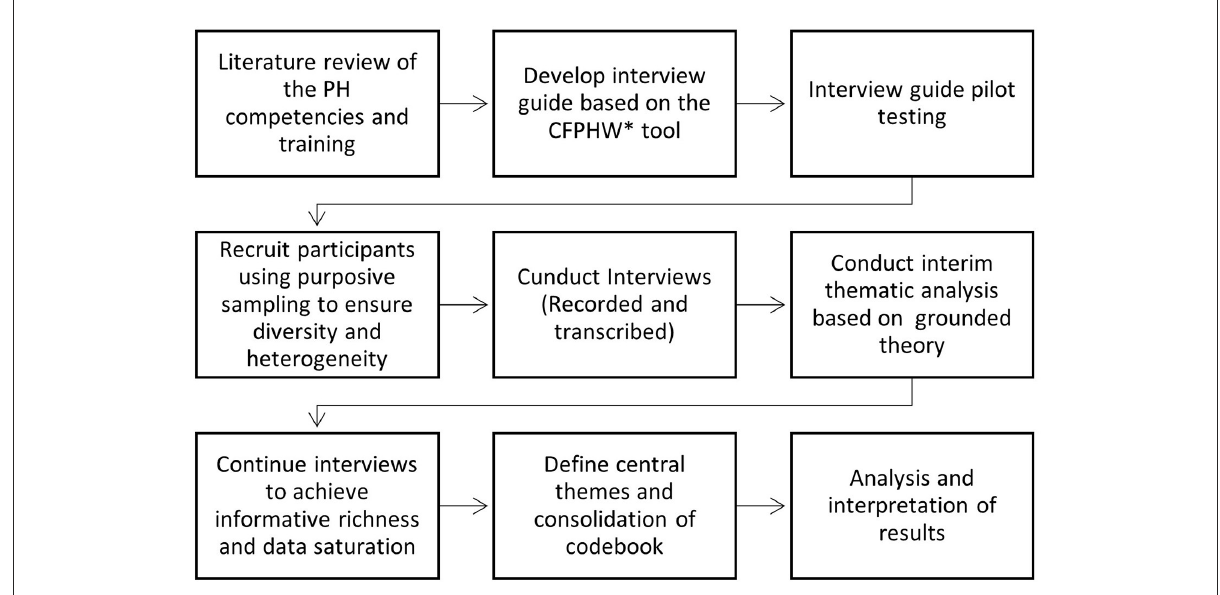
FIGURE1 Study procedure from data collection to the synthesis of local analysis. The * symbol indicates the WHO-ASPHER Competency Framework for the Public Health Workforce in the European